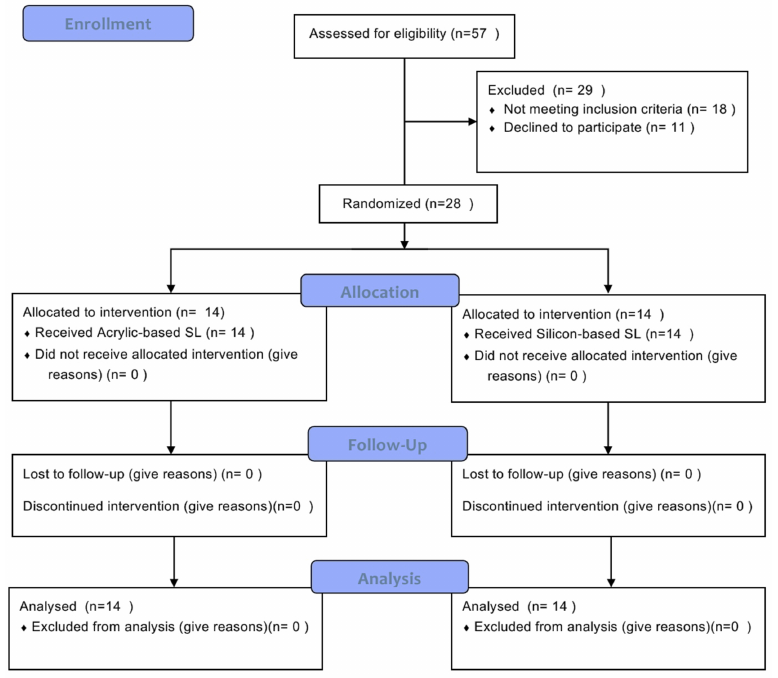
Figure 1. Participants’ flow chart of the study.